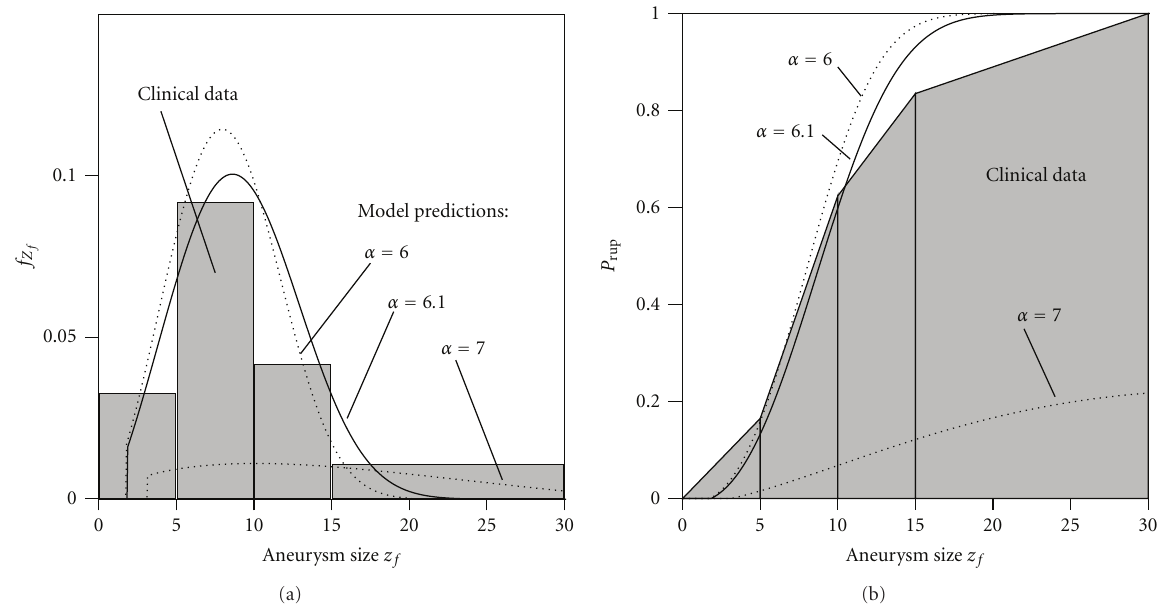
Figure 6: Comparison between clinical data from [54] and predicted risk of aneurysm rupture. Total number of ruptured aneurysms in clinical study: 109. Shaded bars and areas indicate clinical results, and lines indicate model predictions. (a) Density function for risk of rupture versus aneurysm size. (b) Rupture risk (distribution function) versus aneurysm size. The parameter α is the exponent in the evolution law for collagen production, see (4).